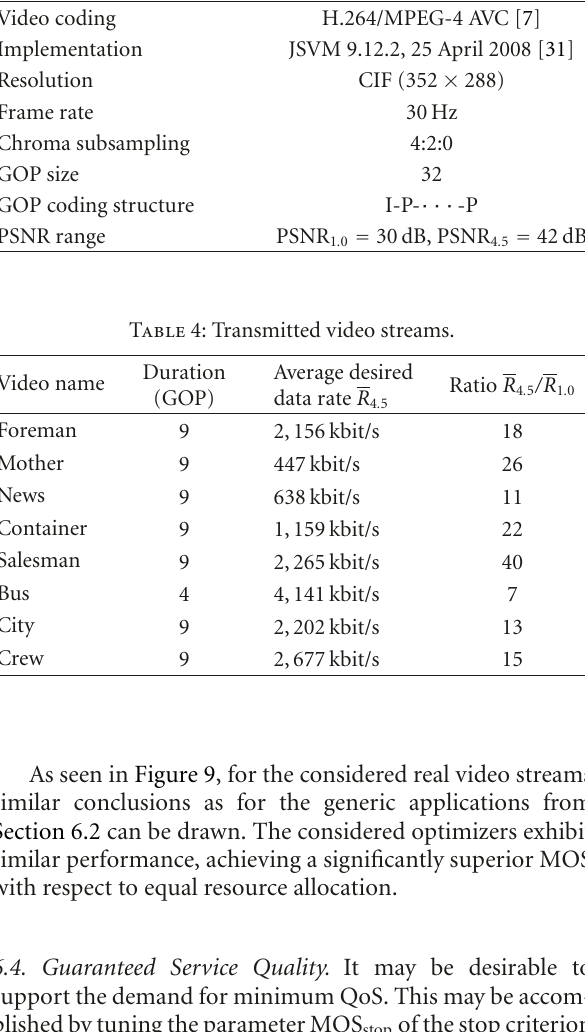
Table 3: Video parameters.